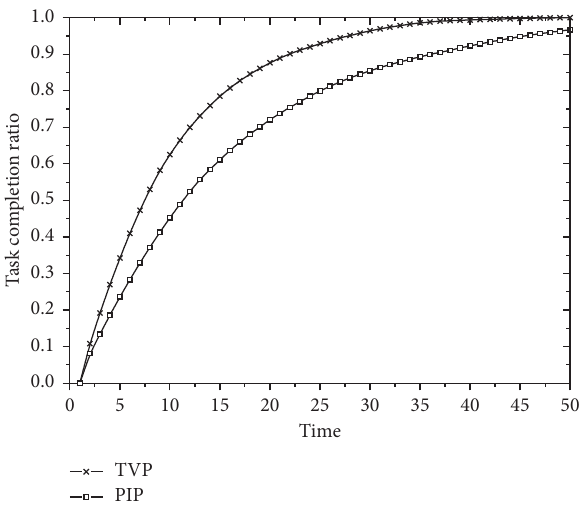
Figure 2: Task type where utility is directly proportional to subtask